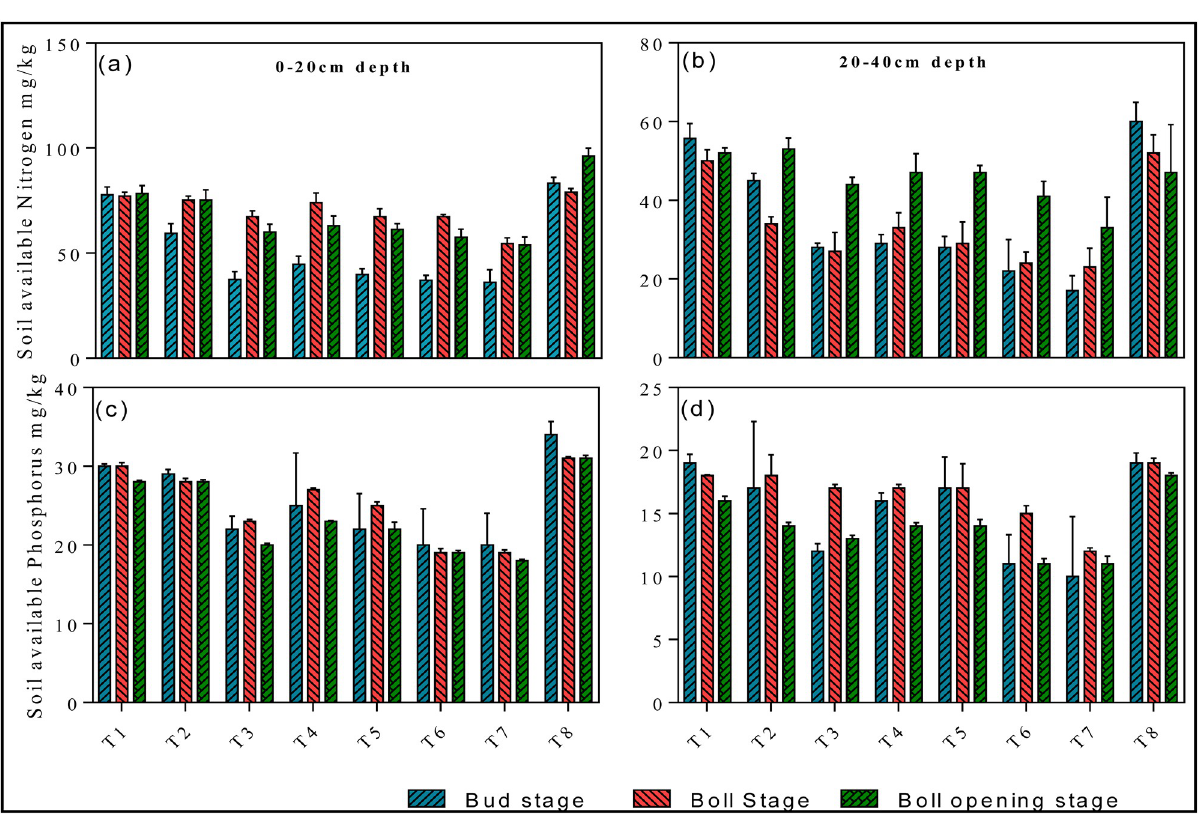
Fig 8. Effects of round irrigation on soil available nitrogen (mg/kg) and soil available phosphorus (mg/kg): Fig (6a) and (6b) represents soil available nitrogen at depth of 0–20 cm and 20–40 cm; Fig (6c) and (6d) represents soil available phosphorus at depth of 0–20 cm and 20–40 cm. Data were presented as the mean ± standard error (SE) of three replicates at a significance level of p < 0.05 (based on ANOVA).